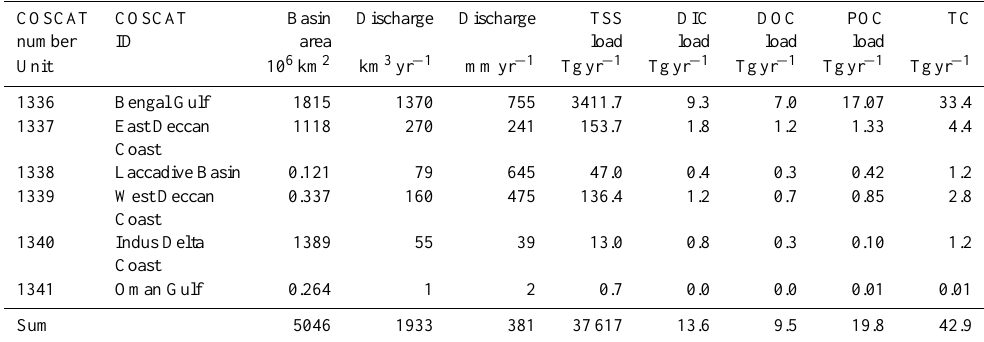
Table 4. Riverine carbon exports from the COSCAT regions in South Asia as estimated by Global NEWS (TSS: Total Suspended Sediment; DIC: Dissolved Inorganic Carbon; DOC: Dissolved Organic Carbon; POC: Particulate Organic Carbon; TC: Total Carbon ( = DIC + DOC +